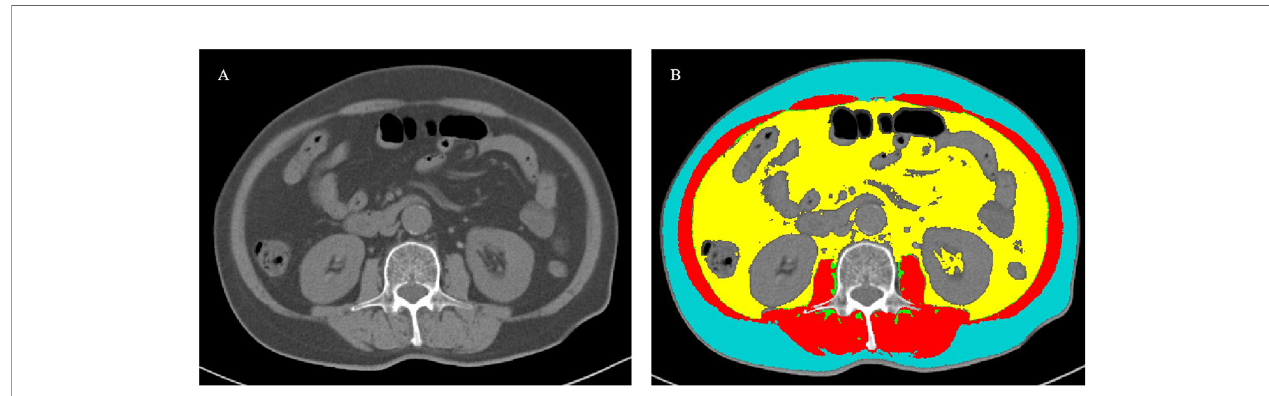
FIGURE 1 | Measurement of body composition parameters with cross-sectional CT images at the third lumbar level. (A) A cross-sectional CT image at the third lumbar level. (B) Body composition automatically calculated using the ABACS Auto Segmentation module in SliceOmatic software (ver. 5.0). Visceral adipose tissue, subcutaneous adipose tissue, intramuscular adipose tissue, and muscle were targeted as yellow, blue, green, and red,